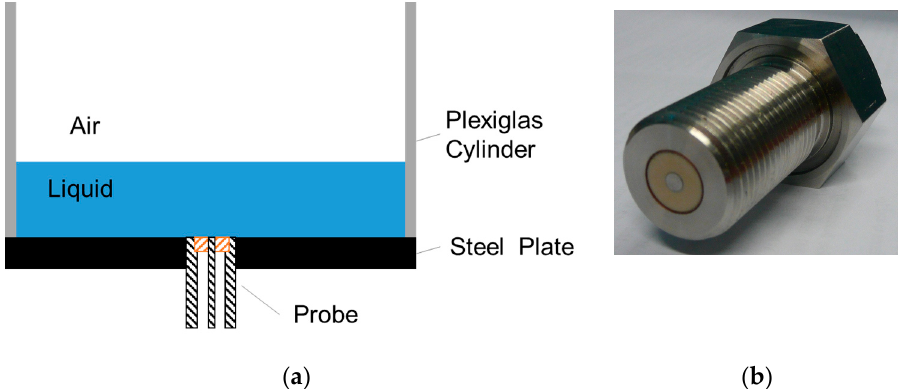
Figure 3. ( a ) Sketch of the experimental set-up and ( b ) picture of the open-ended coaxial probe used in the